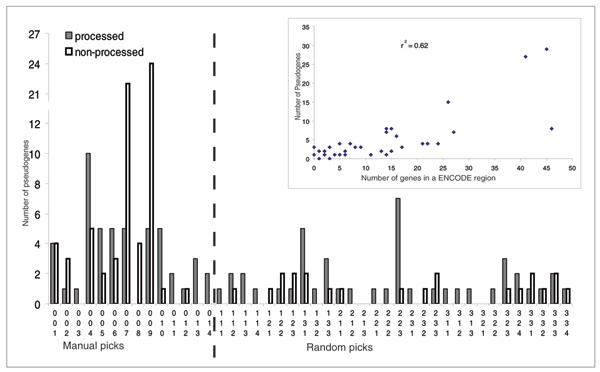
Distribution of 184 pseudogenes in ENCODE regions. Pseudogenes were first grouped into processed and non-processed (duplicated and fragments). Their numbers in the 44 ENCODE regions are plotted. The inserted panel shows that the number of pseudogenes is approximately correlated to that of genes within individual regions.